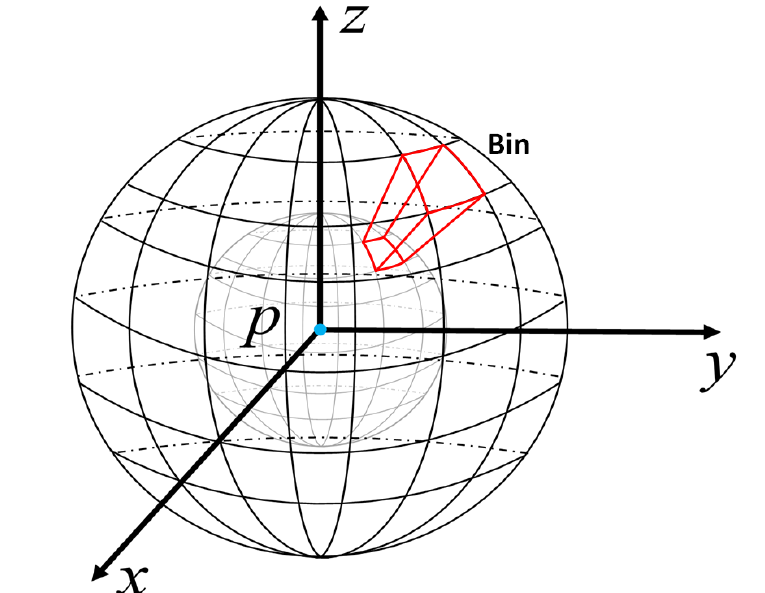
Figure 1. Construction of the bins in